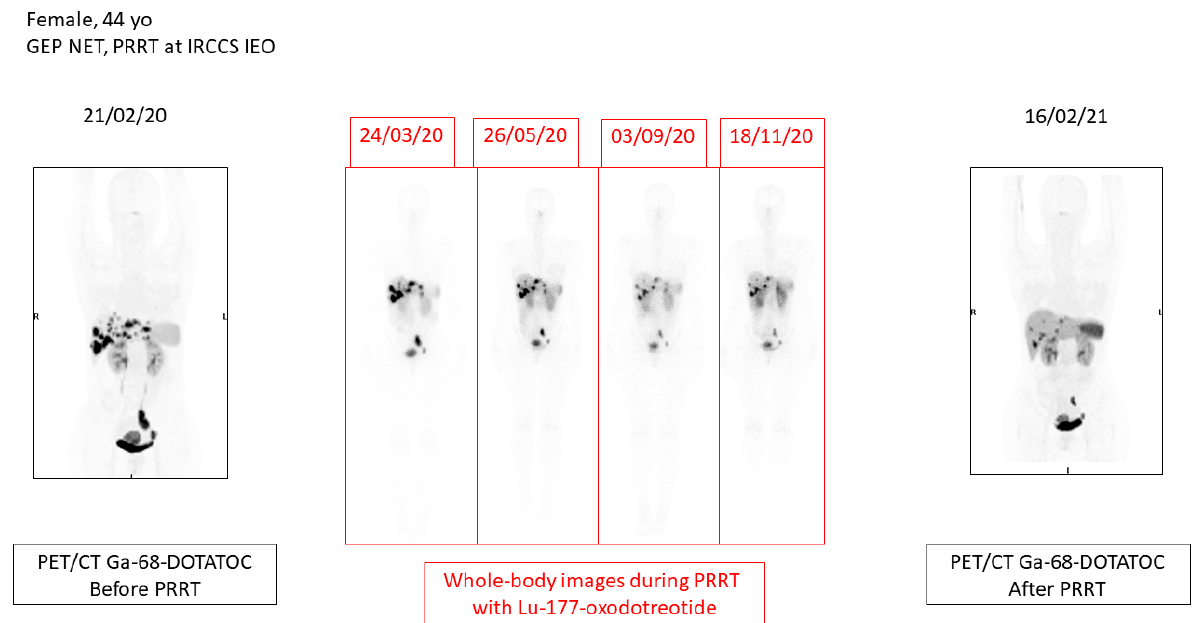
Figure 1. 44-year-old female with GEP-NET who underwent a four-cycle treatment with Lu-177-oxodotreotide at IRCCS IEO. On the left, Ga-68-DOTATOC PET/CT before PRRT shows multiple foci of tracer uptake in the liver and abdomino-pelvic cavity. In the middle, four whole-body scans performed after every therapeutic dose of Lu-177-oxodotreotide, at 8–12 week time intervals. On the right, Ga-68-DOTATOC PET/CT after the last cycle of PRRT, which shows a significant reduction in disease burden with partial response to treatment.